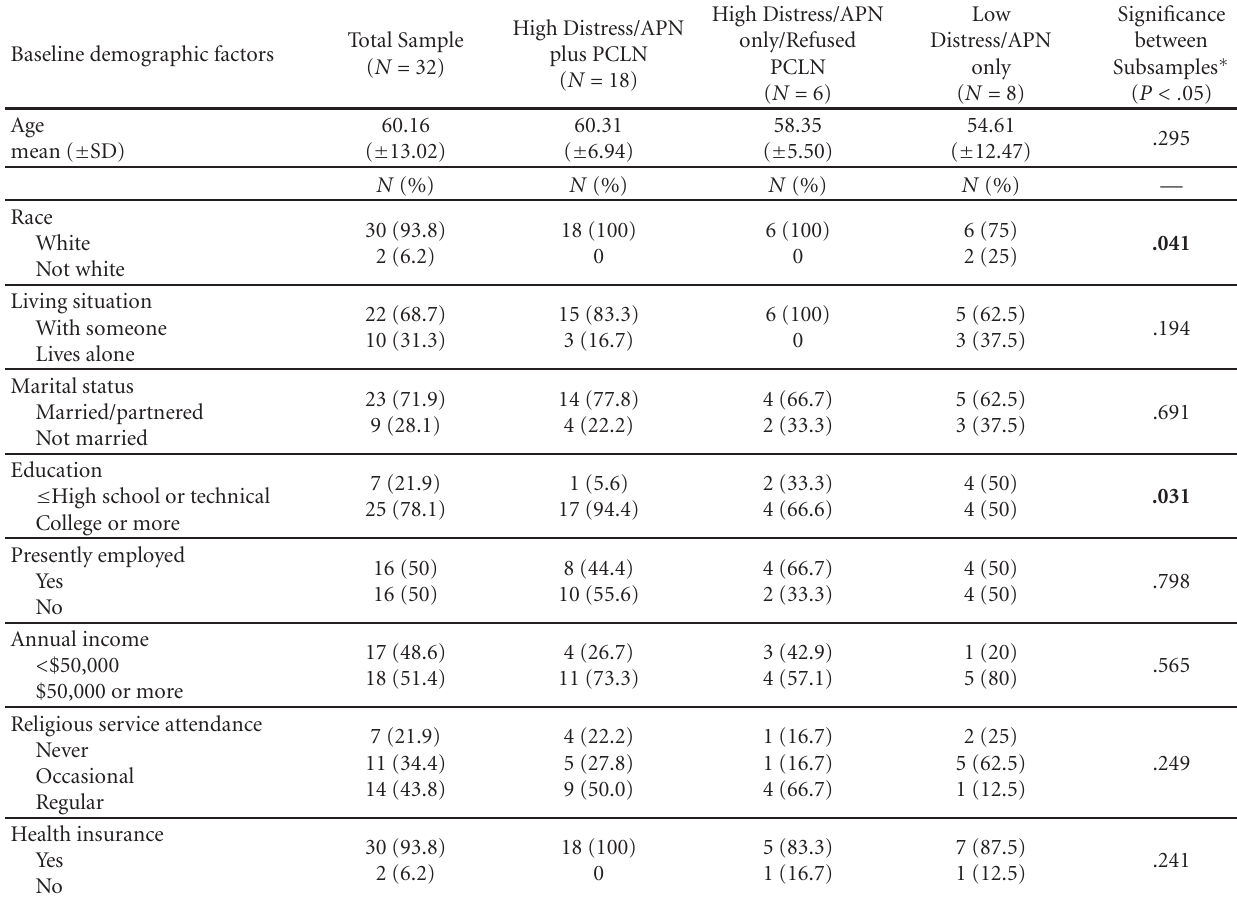
Table 1: Baseline demographic characteristics of the